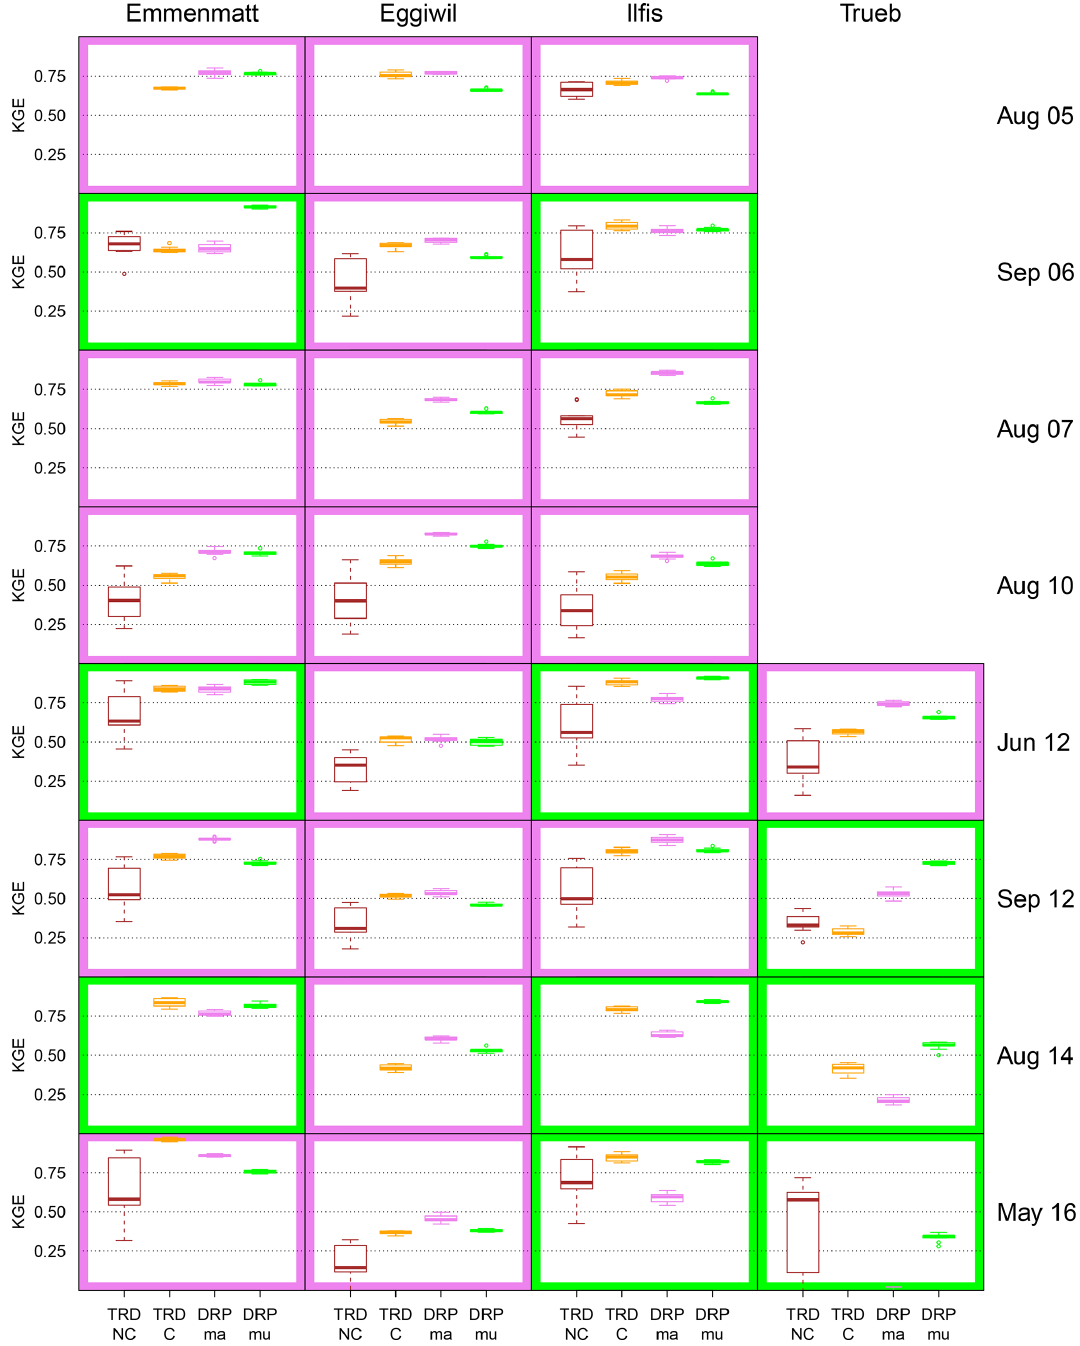
Figure 4. Re-analysis of eight large runoff events from 2005 to 2016 with CombiPrecip data in the four Emme catchments. The box plots represent the simulation results of the different model configurations. TRD-NC stands for uncalibrated PREVAH, TRD-C for calibrated PREVAH, DRP-ma for RGM-PRO relying on Margreth maps and DRP-mu for RGM-PRO based on Müller maps. The border colour reveals whether DRP-ma (pink) or DRP-mu (light green) performed better in terms of median KGE. Where no box plot is visible, all KGE values were below zero. The spread in KGE of uncalibrated PREVAH results from 10 random hydrological parameter sets out of 4000 Monte Carlo simulations, whereas uncertainty from calibrated PREVAH originates from the 10 parameter sets with highest KGE for the May 2016 event in Emmenmatt. The spread in RGM-PRO arises from simulations with 10 hydrological parameter sets lying in narrow ranges determined by sprinkler experiments (Antonetti et al.,